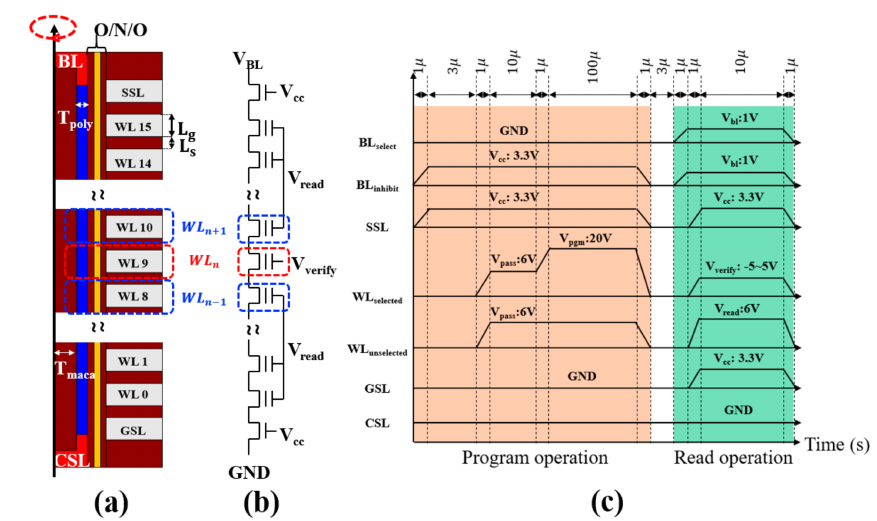
Figure 1. ( a ) Cross-section view of the simulated 3D NAND Flash memory. Bit-Line (BL) and Common Source Line (CSL) are doped with a donor concentration of 10 19 cm − 3 , and the channel is doped with an acceptor concentration of 10 15 cm − 3 . O / N / O is tunneling oxide, nitride trap layer, and blocking oxide. Each thickness is 4 / 7 / 7 nm. In addition, the channel thickness (T poly ) is 10 nm, and the macaroni oxide thickness (T maca ) is 20 nm. ( b ) Equivalent circuit and bias condition of the read scheme with 3D NAND flash memory. ( c ) Pulse diagrams corresponding to the bias methods for the conventional read